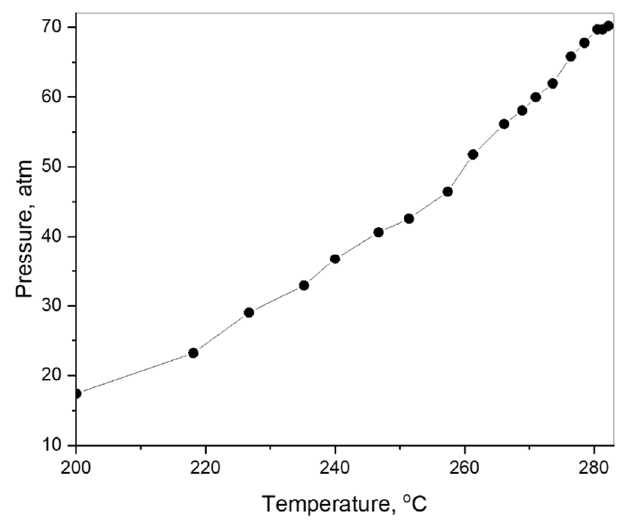
Figure 4. Pressure of saturated water vapor as a function of temperature.